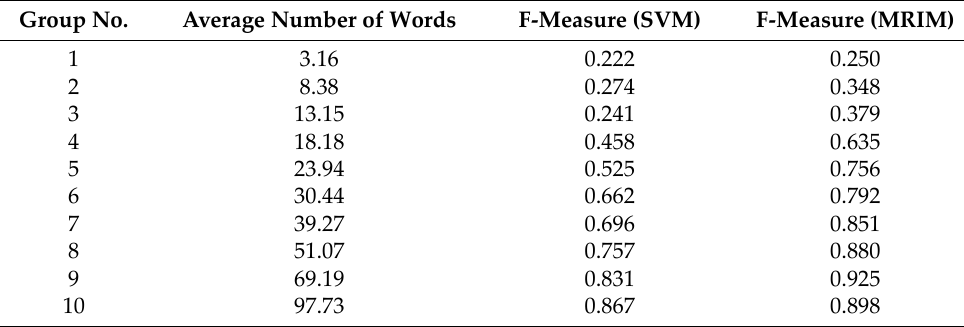
Table 7. Classification results of datasets grouped by the number of words. Group